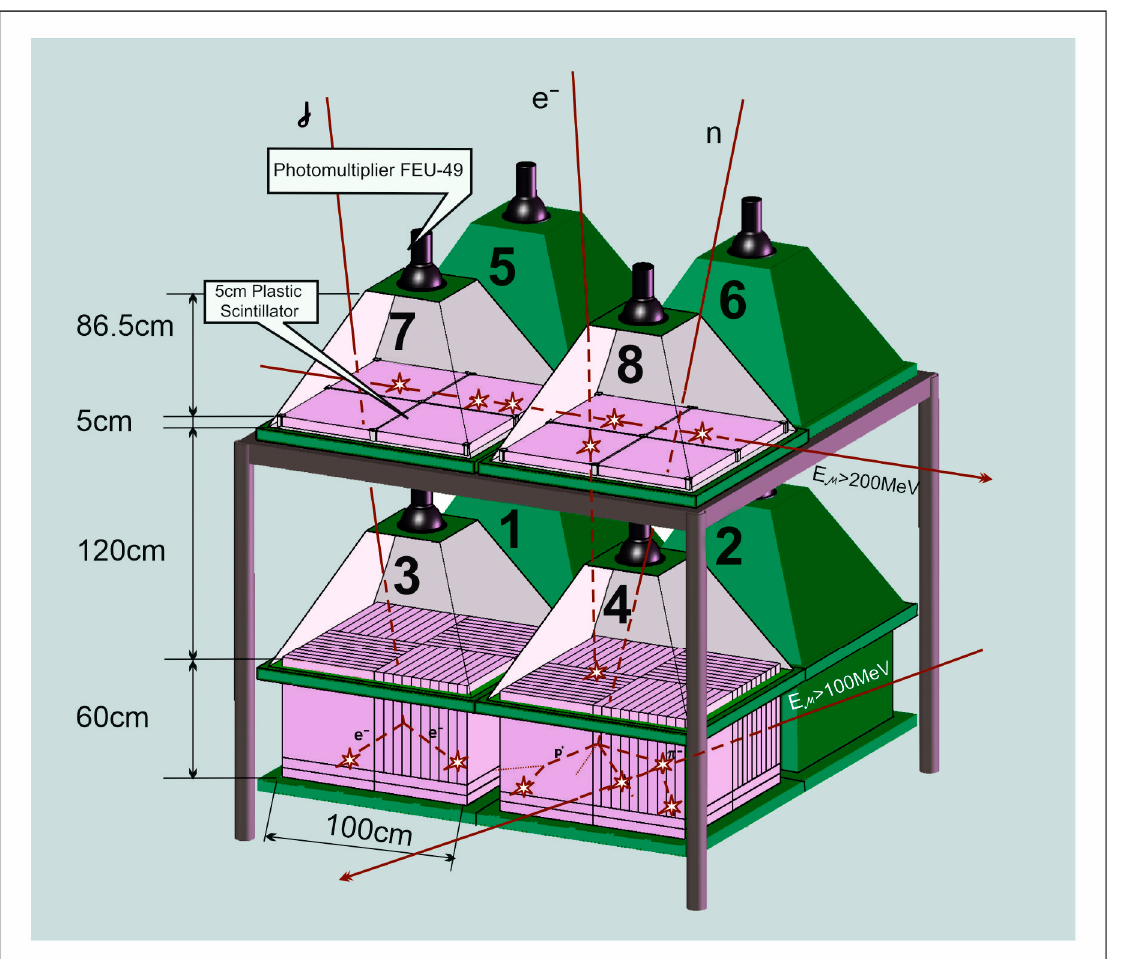
Figure 2. Assembly of ASNT with a schematic view of the different particles traversing the detector. Both upper and lower scintillators register TGE electrons; gamma rays and neutrons are registered by invoking the veto option (no signals in the upper scintillators). ©PRD. Reproduced with permission.